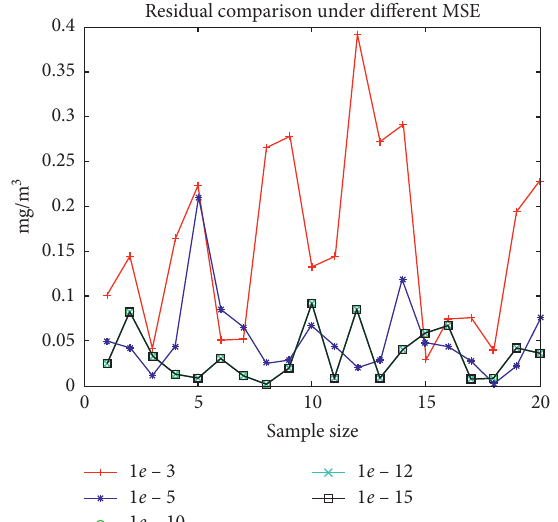
Figure 6: Residual comparison under different MSE.